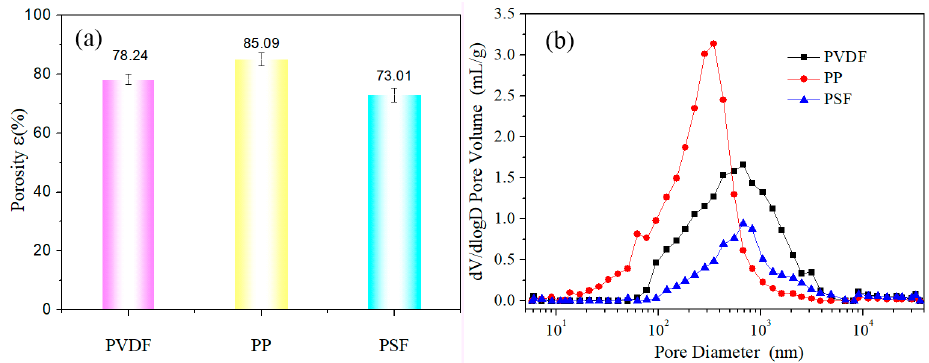
Figure 2. Membrane wall porosity ( a ) and pore size distribution ( b ) of three membranes.